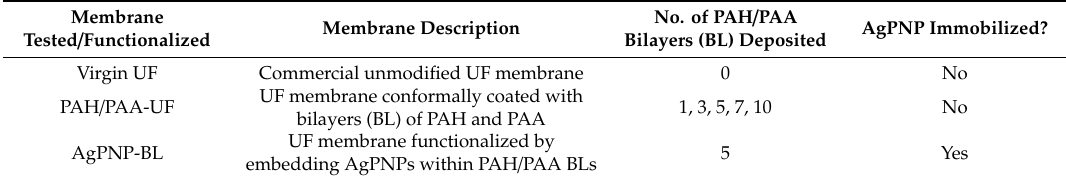
Table 1. UF membranes tested and functionalized for di ff erent experiments in this